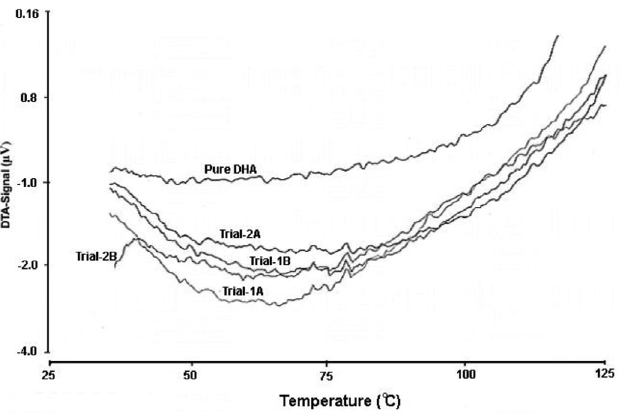
FIGURE 4 - DTA comparison of pure DHA and DHA granules.